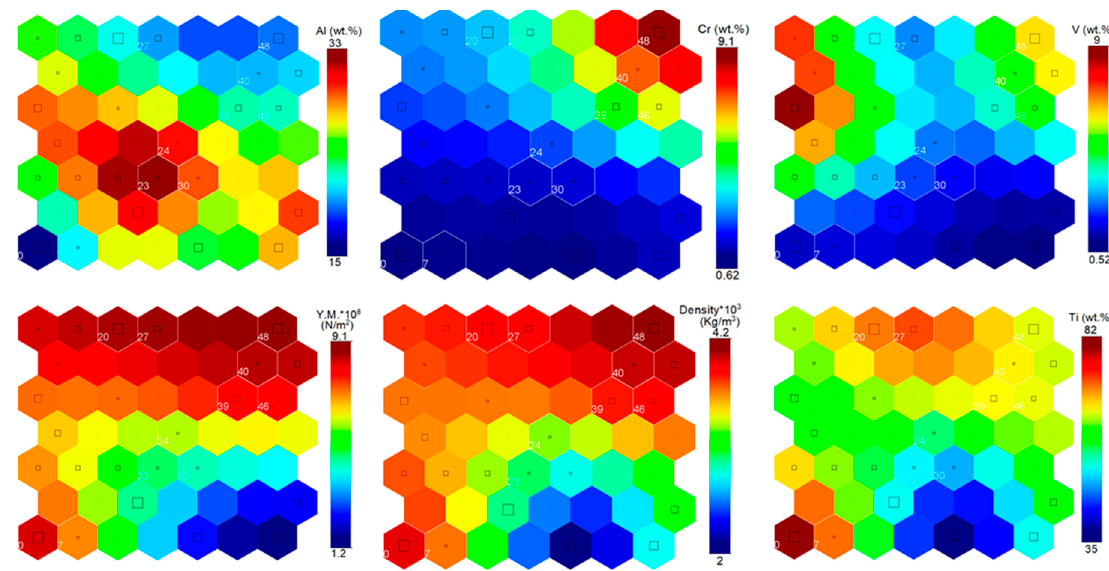
Figure 3. Phases that are not desired in the present system.